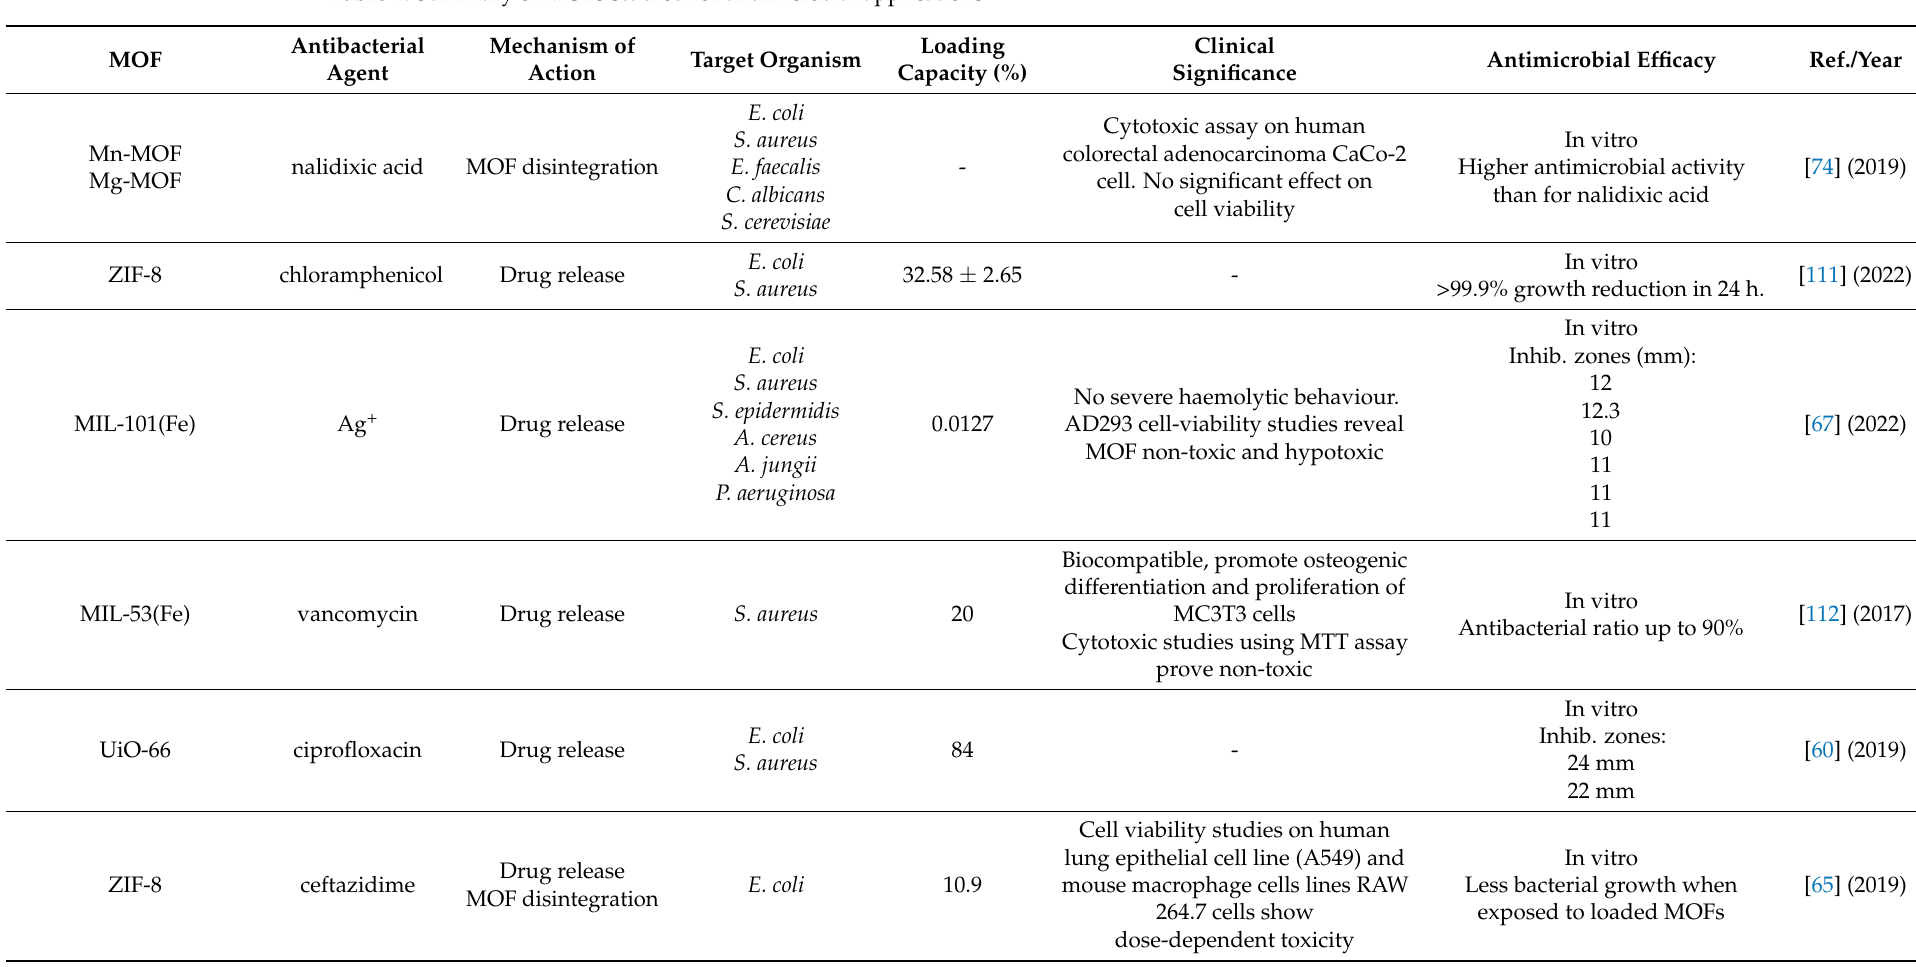
Table 1. Summary of MOFs studied for antimicrobial